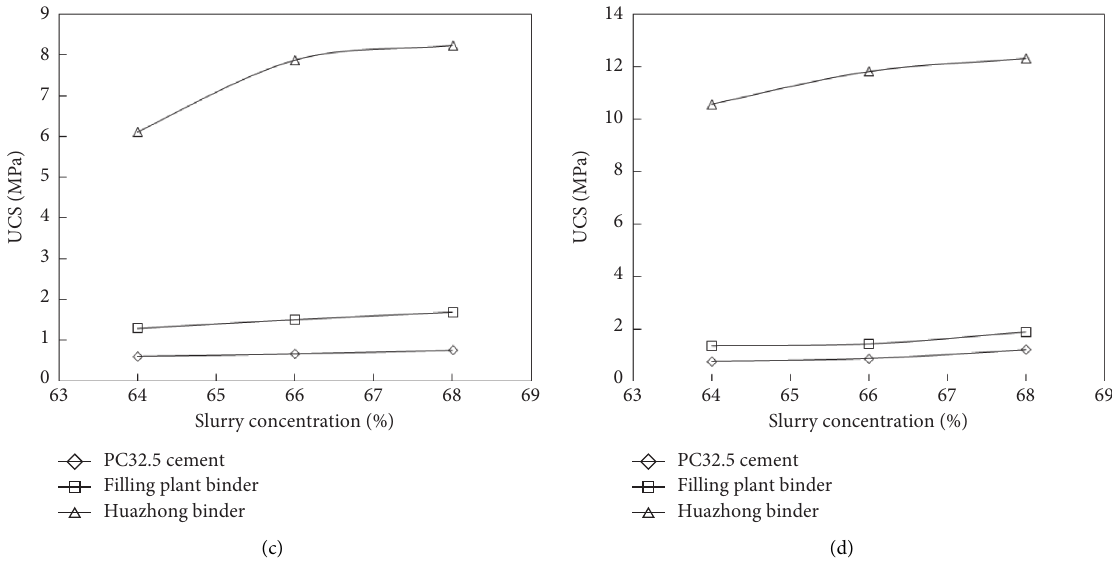
Figure 7: Variation of UCS with slurry concentration. (a) 3 d curing time. (b) 7d curing time. (c) 28d curing time. (d) 60d curing